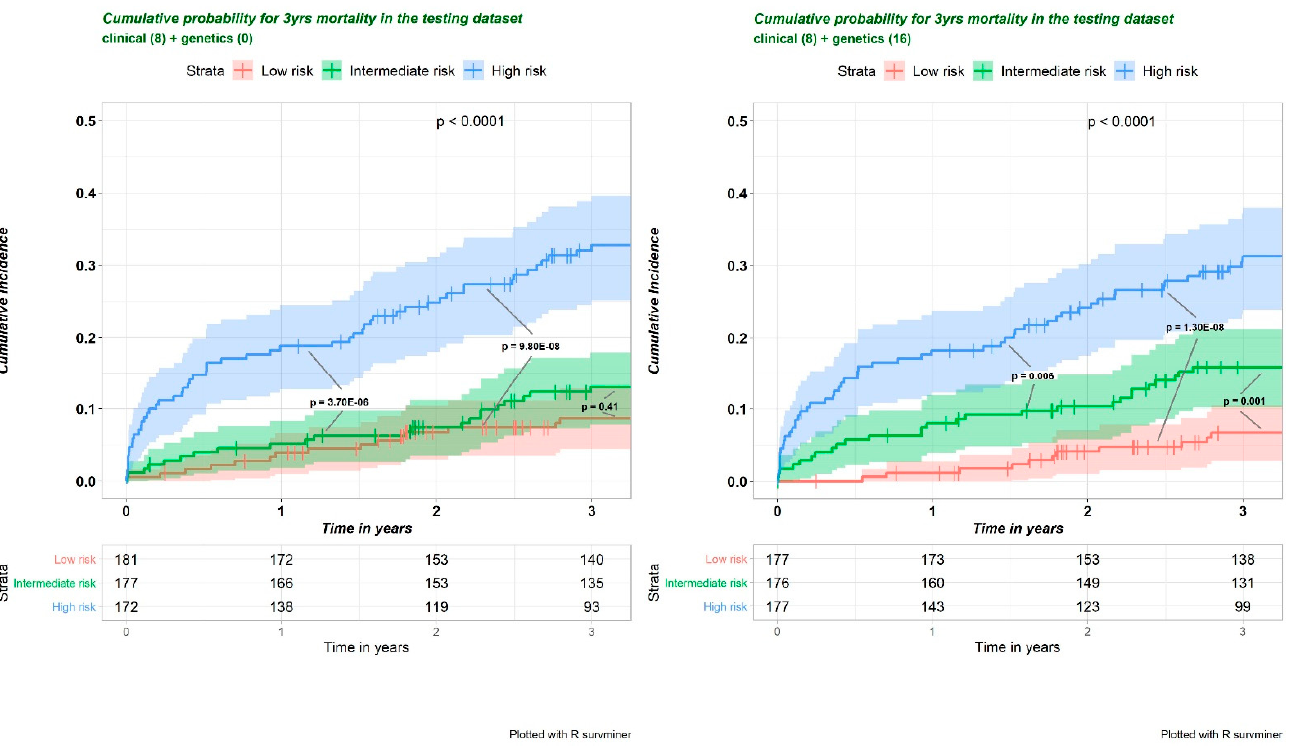
Figure 8. Kaplan–Meier analysis of post-IS cumulative probability for 3-year mortality in the testing dataset. Assuming three subgroups with different survival probability in the testing dataset to determine the effect size of each feature included in the multivariate Cox proportional hazards regression model. The p -value derived from the log-rank test is labeled. For all analyses, p < 0.05 was considered statistically significant. For all post hoc pairwise tests, p values were adjusted according to the Benjamin–Hochberg procedure. The number at risk is listed in the table. This figure adapted from Li J (2022) [95] with CC BY 4.0 .